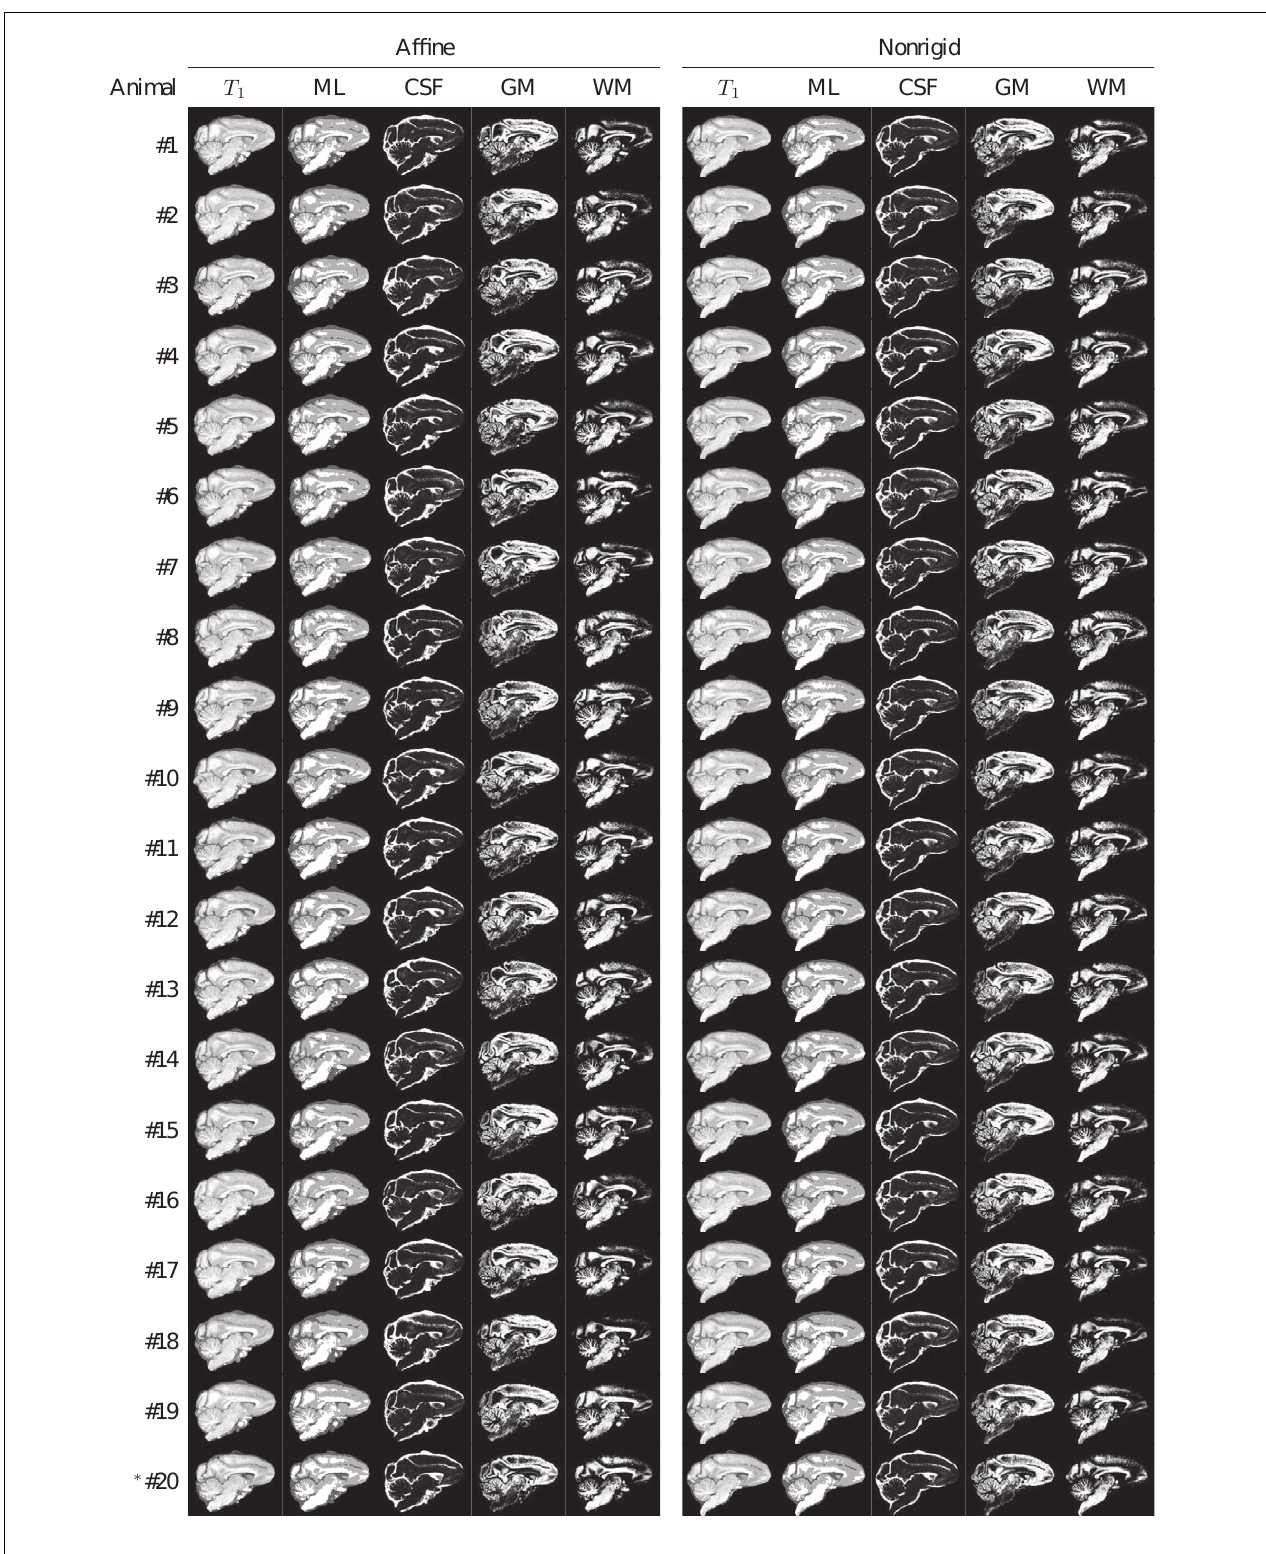
FIGURE 10 |AnimalT1-weighted images, maximum-likelihood segmentations, and tissue probability maps, all reformatted to the INIA19 atlas coordinate system via affine (left column) and